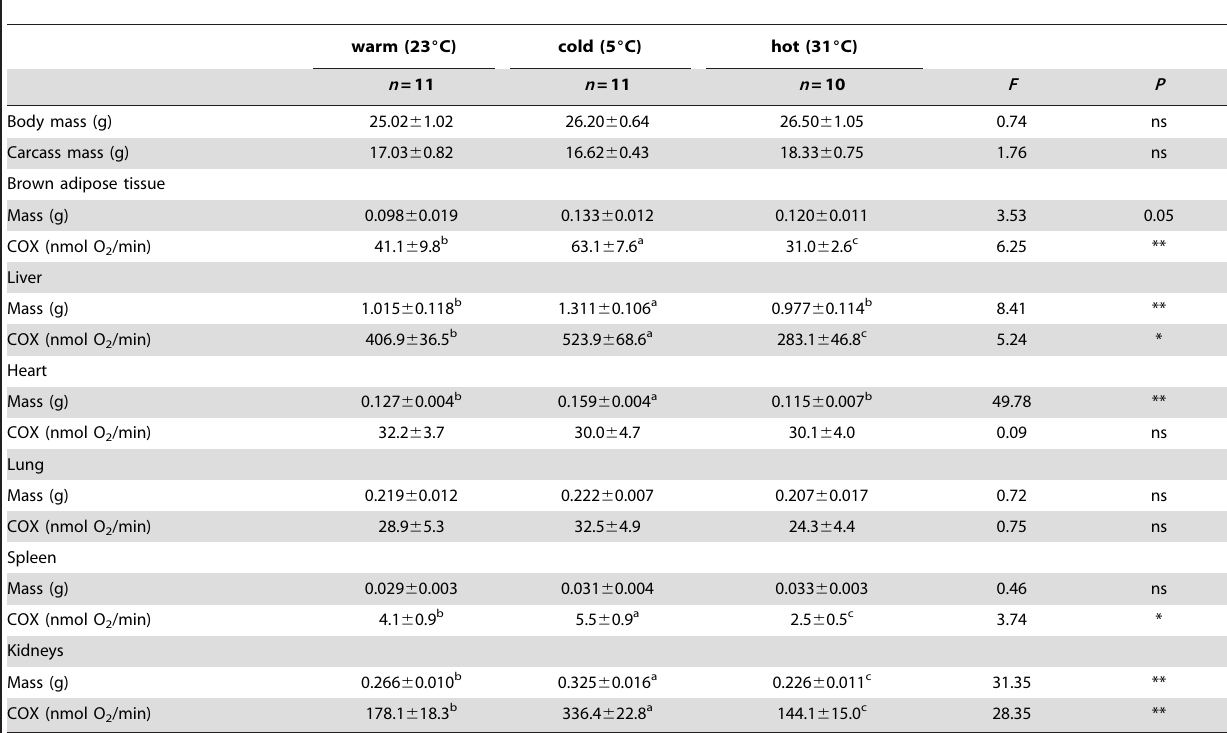
Table 1. Masses and cytochrome c oxidase (COX) activity of brown adipose tissue and visceral organs in striped hamsters acclimated to warm, cold and hot conditions.